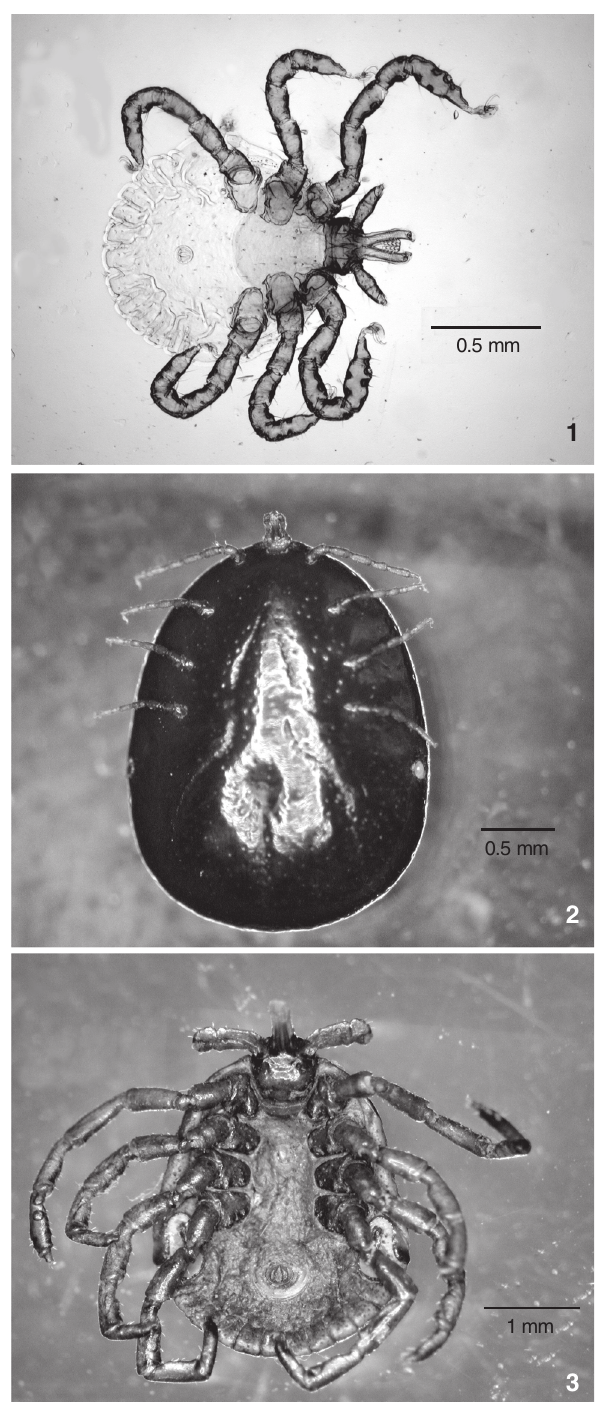
Figures 1-3. Life stages of A. rotundatum , ventral aspect: (1) larva; (2) nymph; (3) adult